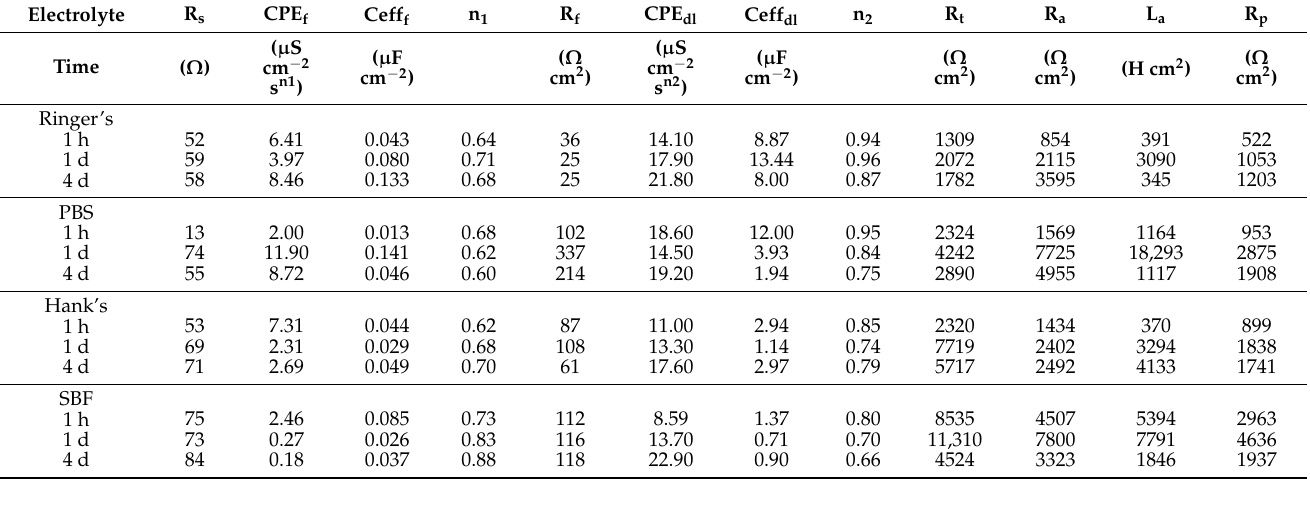
Figure 6. Typical Nyquist plots with respective fitting for AZ31B specimens after 1 h, 1 d, and 4 d of immersion at the open circuit potential (OCP) in ( a ) Ringer’s, ( b ) PBS, ( c ) Hank’s , and ( d ) SBF solutions. Samples had an exposed area of Table 6. Fitting results from EIS measurements for the AZ31B Mg alloy in Ringer’s, PBS, Hank’s, and SBF solutions after 1 0.78 cm 2 . Fitting results shown in Table 6. h, 1 d, and 4 d of immersion. The EEC used for fitting is shown in Figure 7. Relative error for each parameter ≤ 5% and χ 2 ≤ 1 × 10 − 3 .